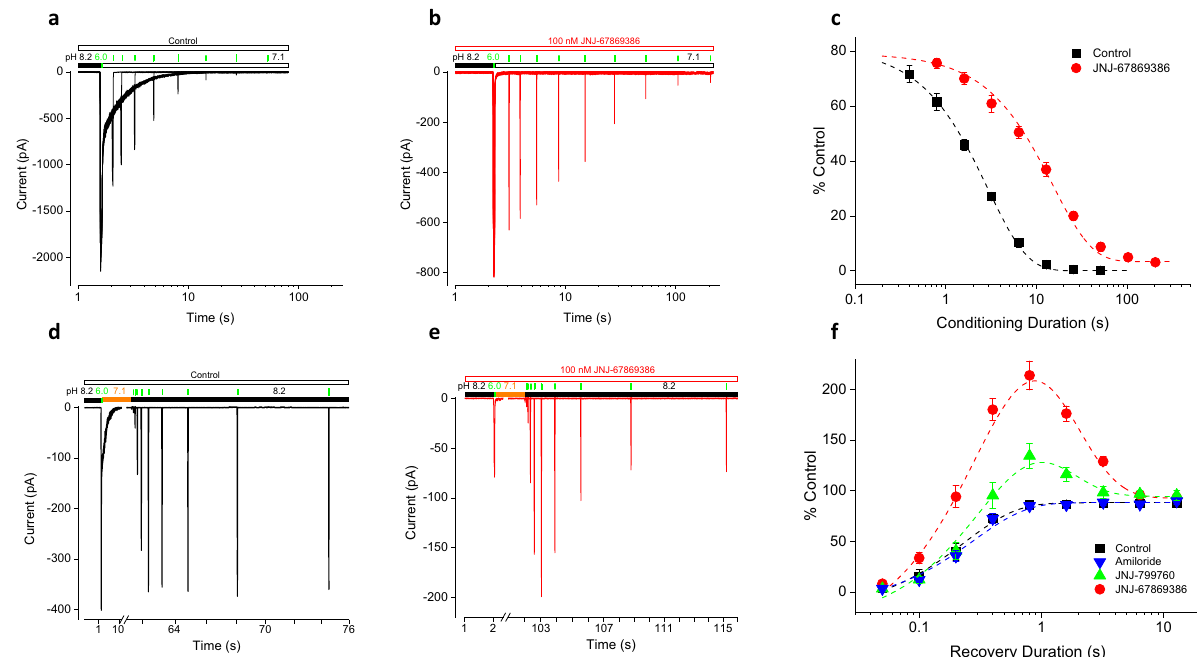
Fig. 3 Effect of JNJ-67869386 and JNJ-799760 on the kinetics of closed-state desensitization. a and b Current traces showing the time course of development of pH 7.1-induced desensitization without ( a ) or with ( b ) 100 nM JNJ-67869386. Brief pH 6.0 test pulses (thin vertical bars above the current traces) are applied immediately before and at various times during the pH 7.1 application. Inter-pulse interval = 120 s ( a ) and 150 s ( b ). c Summary of all experiments like ( a ) and ( b ). Data are normalized to the fi rst pH 6.0 (pre-pH 7.1) peak and fi tted to a single exponential function with time constants of 2.9 ± 0.1 s (control; n = 6) and 15.1 ± 1.3 s (JNJ-67869386; n = 6), respectively. The JNJ-67869386 data are statistically different from control ( p < 0.001; Two- way ANOVA). d and e Current traces showing the time course of recovery from pH 7.1-induced desensitization without ( d ) or with ( e ) 100 nM JNJ- 67869386. A 60/100 s (control/JNJ-67869386) pH 7.1 pulse is preceded by a brief pH 6.0 pulse and followed by a pH 8.2 pulse interspersed with brief pH 6.0 pulses (thin vertical bars above the current traces) at various intervals. f Summary of all experiments like ( d ) and ( e ). Data are normalized to the fi rst pH 6.0 (pre-pH 7.1) peak and fi tted to a single (control/30 µ M amiloride) or double (100 nM JNJ-67869386/JNJ-799760) exponential function with time constants of 231.5 ± 17.4 ms (control; n = 6), 277.6 ± 35.9 ms (amiloride; n = 4), 381.0 ± 85.1 ms/1.4 ± 0.4 s (JNJ-67869386; n = 6) and 400.0ms/ 1.0 ± 0.4 s (JNJ-799760; n = 6), respectively. Data for JNJ-67869386 and JNJ-799760 ( p < 0.001 for both), but not amiloride ( p > 0.5), are statistically different from control (two-way compound bound, consistent with the conclusions reached from Fig. 3. A small fraction of channels still recovers slowly, resem- bling the kinetics of current recovery from compound inhibition